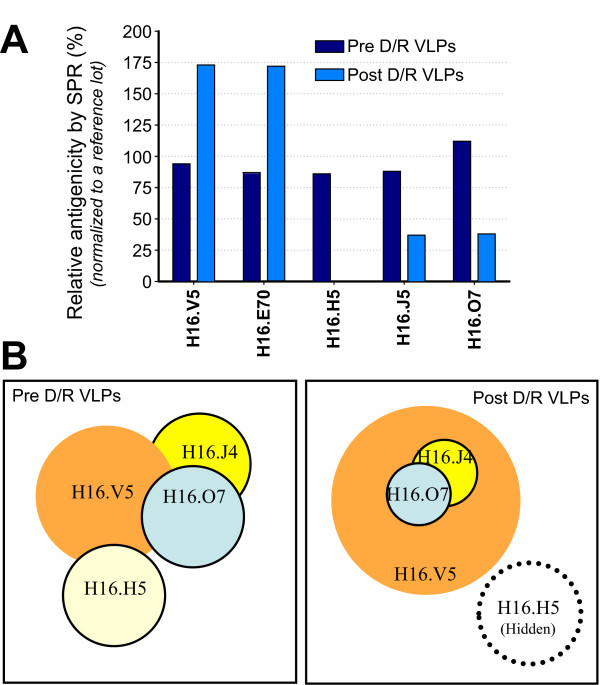
Quantitative assessment of the impact of D/R on the binding affinities of different antibodies, specifically captured by chemically immobilized RAMFc [36], to HPV16 VLPs by SPR. (A) Enhanced binding of neutralizing mAbs (V5, E70) and greatly reduced binding of linear epitope targeting mAbs (J4, O7 and H5) upon VLP reassembly. (B) Relative footprint changes of anti-HPV 16 L1 mAbs and their approximate degree of overlapping in pre- and post-D/R samples-data obtained with pair-wise epitope mapping.